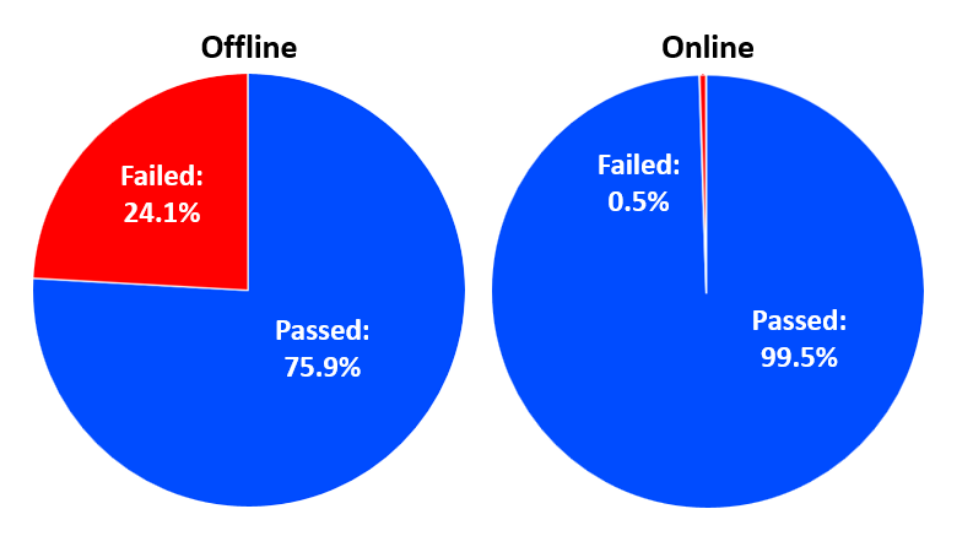
Figure 3. End-of-term performances: